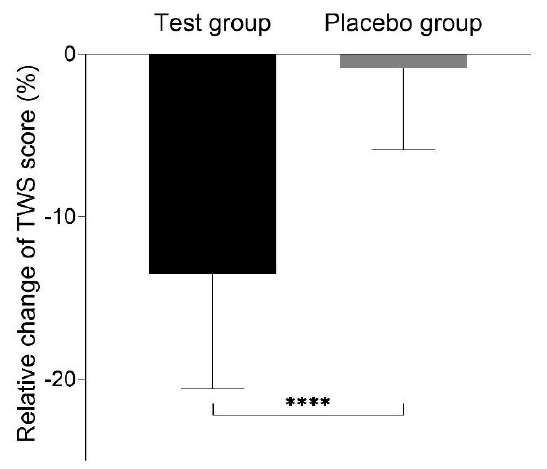
Figure 5. Relative change of total wrinkle score (TWS) from baseline after 12 weeks of supplementation for placebo and test group; **** p < 0.0001.